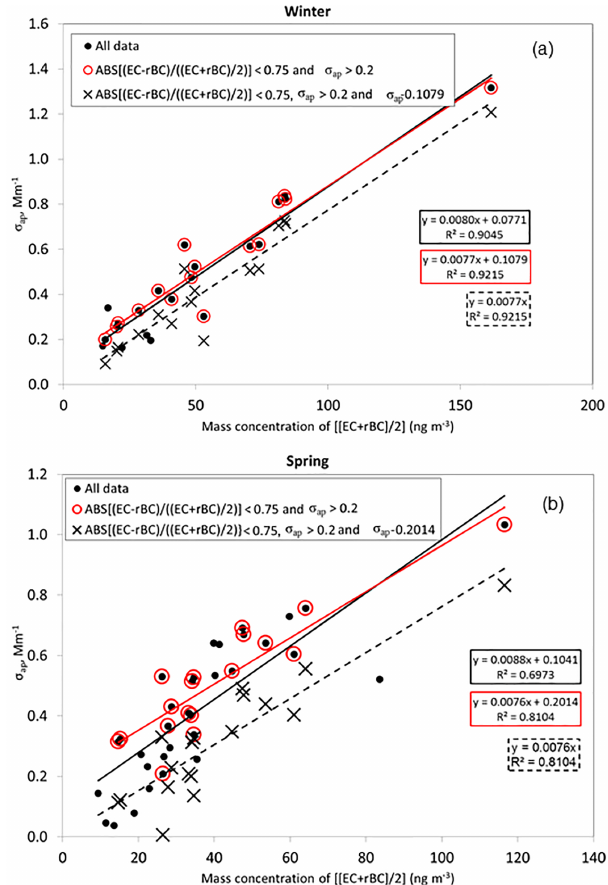
Figure 9. Light absorption coefficient ( σ ap ) at 550nm versus the mass concentration of the average of EC and rBC for winter (a) and spring (b) . Each plot shows all available data (black dots: 31 spring points and 21 winter points), a subset of all data scrutinized for closer agreement between EC and rBC and higher σ ap (red circles: 18 spring points and 16 winter points) and the scrutinized subset with the intercept subtracted (black crosses). See text for discussion of the